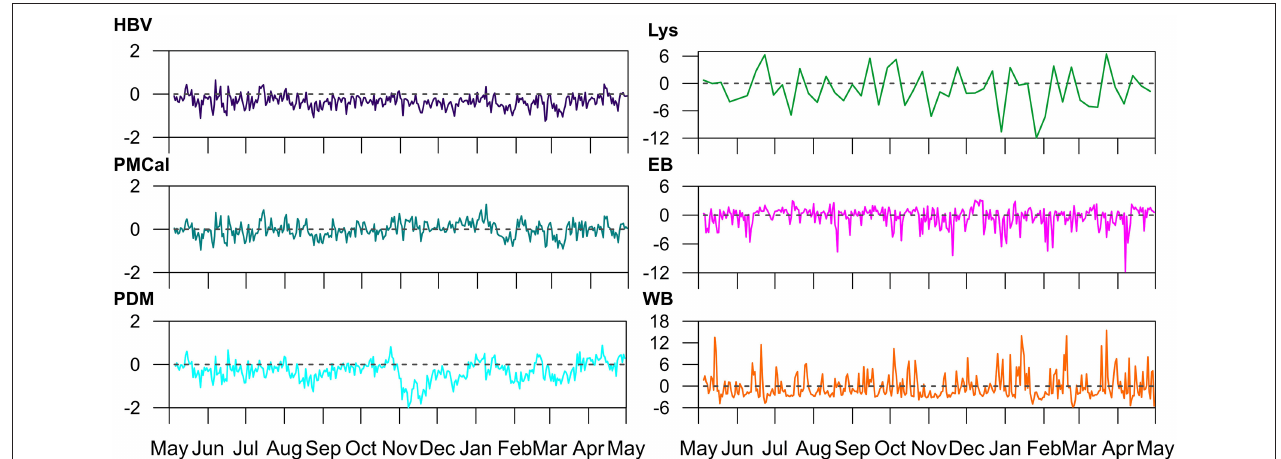
FIGURE 6 | Daily differences in evapotranspiration between the methods and the eddy-covariance (in mm). Methods include: PDM and HBV-light hydrological models, lysimeters (Lys), energy balance (EB), water balance (WB), and the calibrated evapotranspiration equation (PMCal).